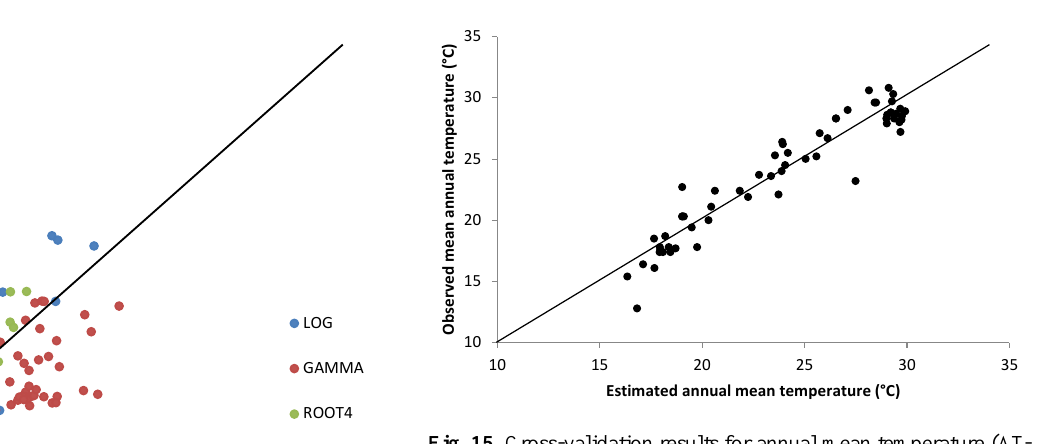
Figure 13 Observed and modelled 10-year return period daily rainfall totals for Network A. Figure 15 Cross-validation results for annual mean temperature (ATBAR).